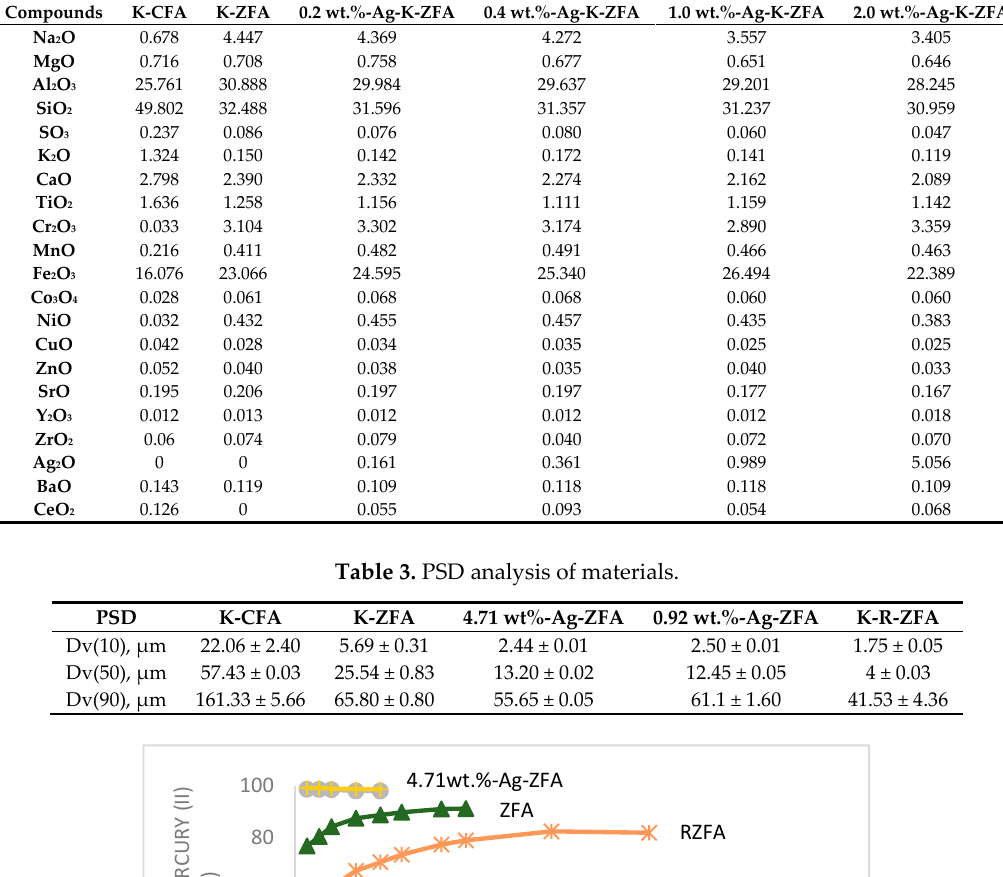
Table 2. Chemical composition of materials.